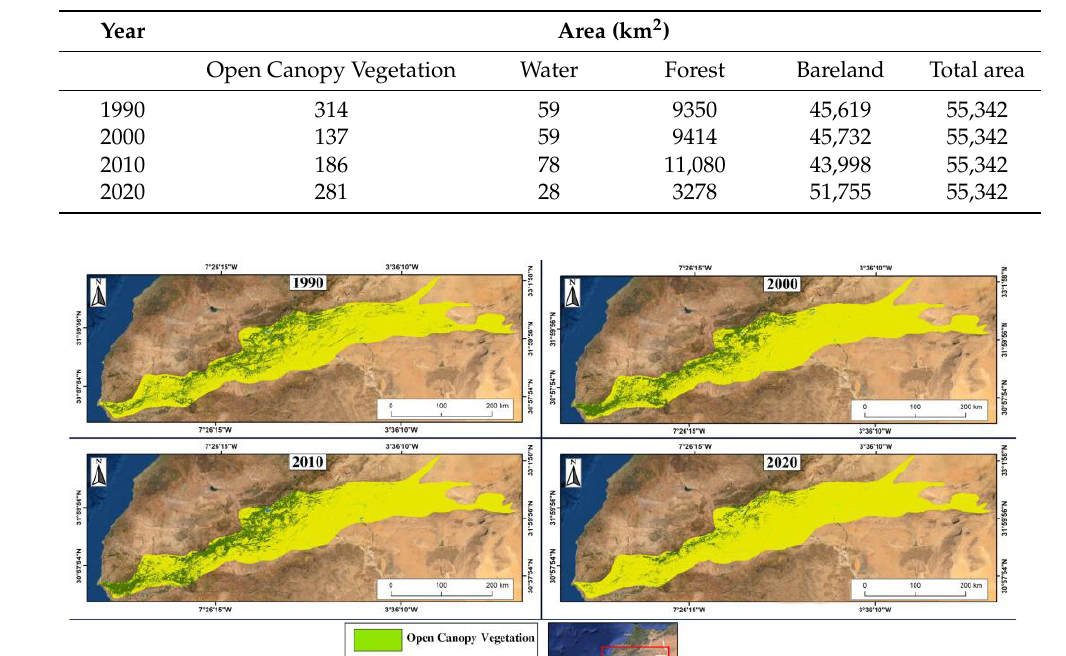
Table 3. Accuracy assessment in (%) from 1990 to 2020 land-use classification using the SVM method in the High Atlas Mountains of Morocco.